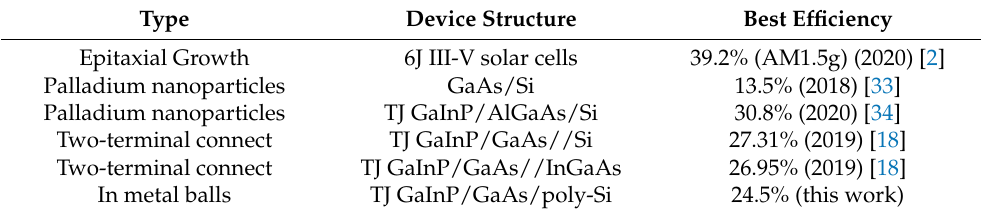
Table 4. Comparison of mechanically Stacked Solar Cells with the epitaxial growth 6J III-V solar